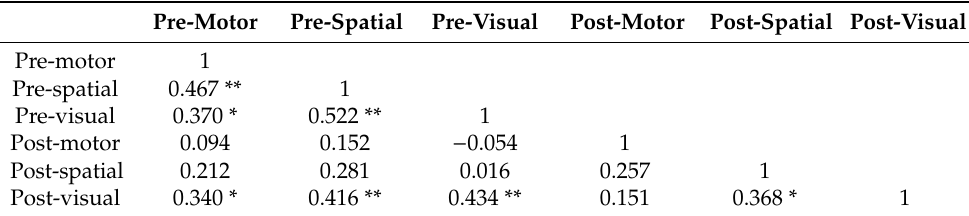
Table 2. Correlations among